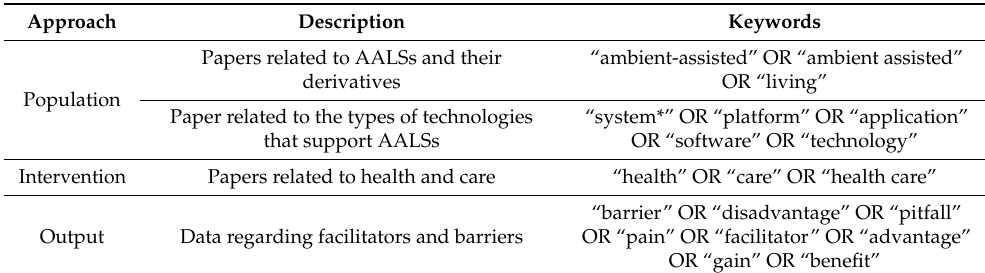
Table 1. Description of the search